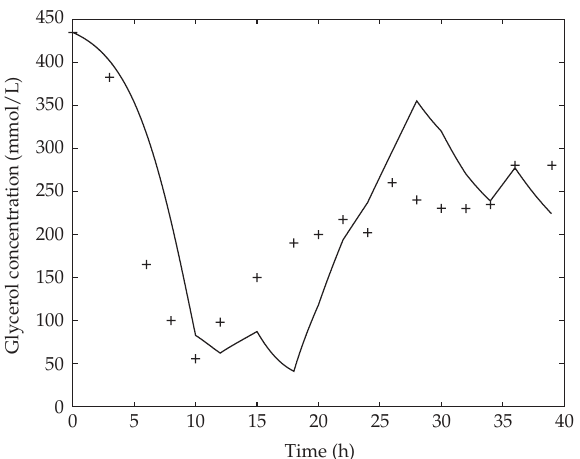
Figure 3: Comparison of glycerol concentration between experimental data and computational results.